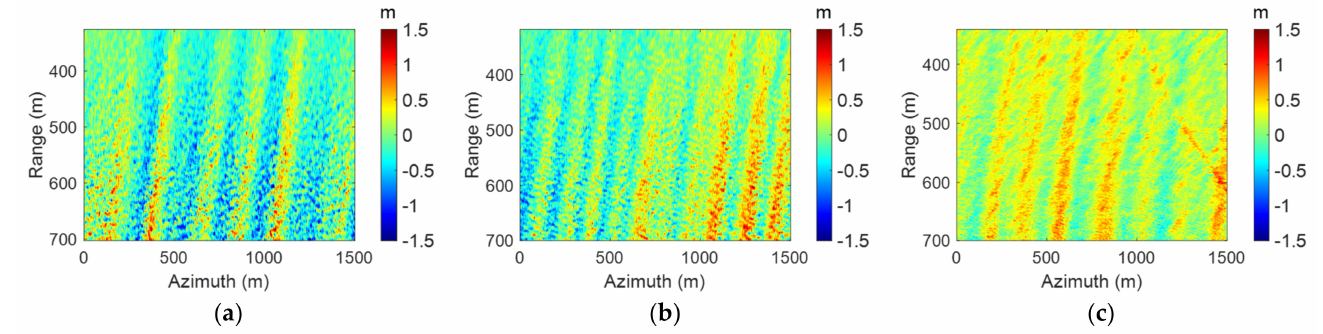
Figure 6. The relative SSE retrieved from IRA images. ( a ) RZ14. ( b ) RZ16. ( c )